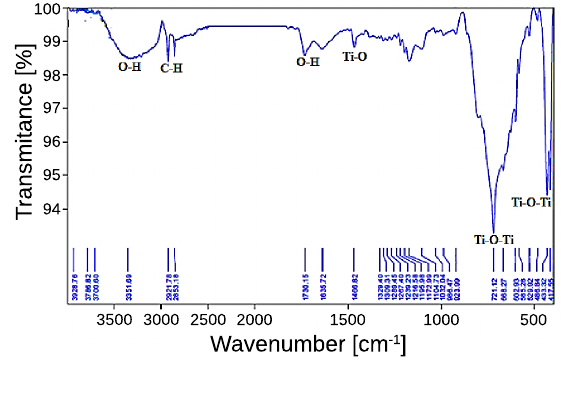
Figure 5: FTIR of TiO 2 -NPs.